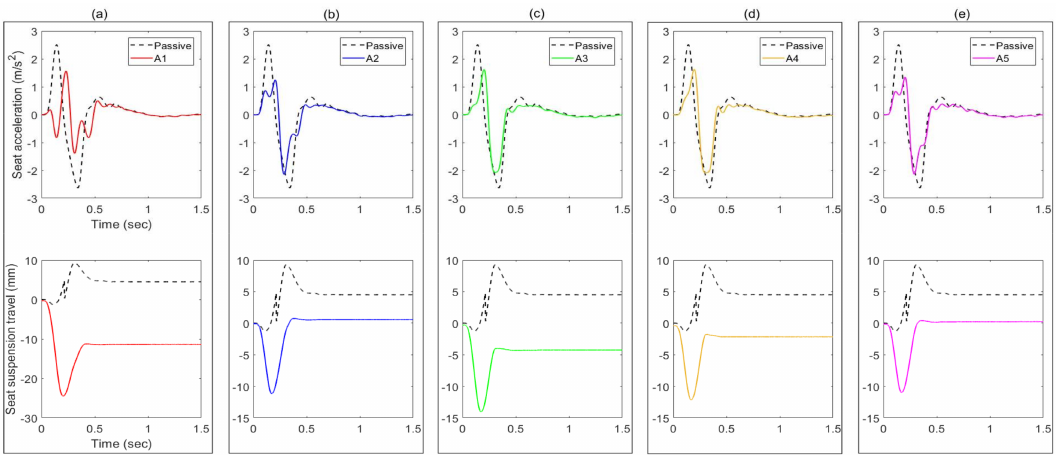
Figure 22. Measured time responses of the passive and active seat suspensions when subject to a bump road input. ( a ) A1; ( b ) A2; ( c ) A3; ( d ) A4; ( e )